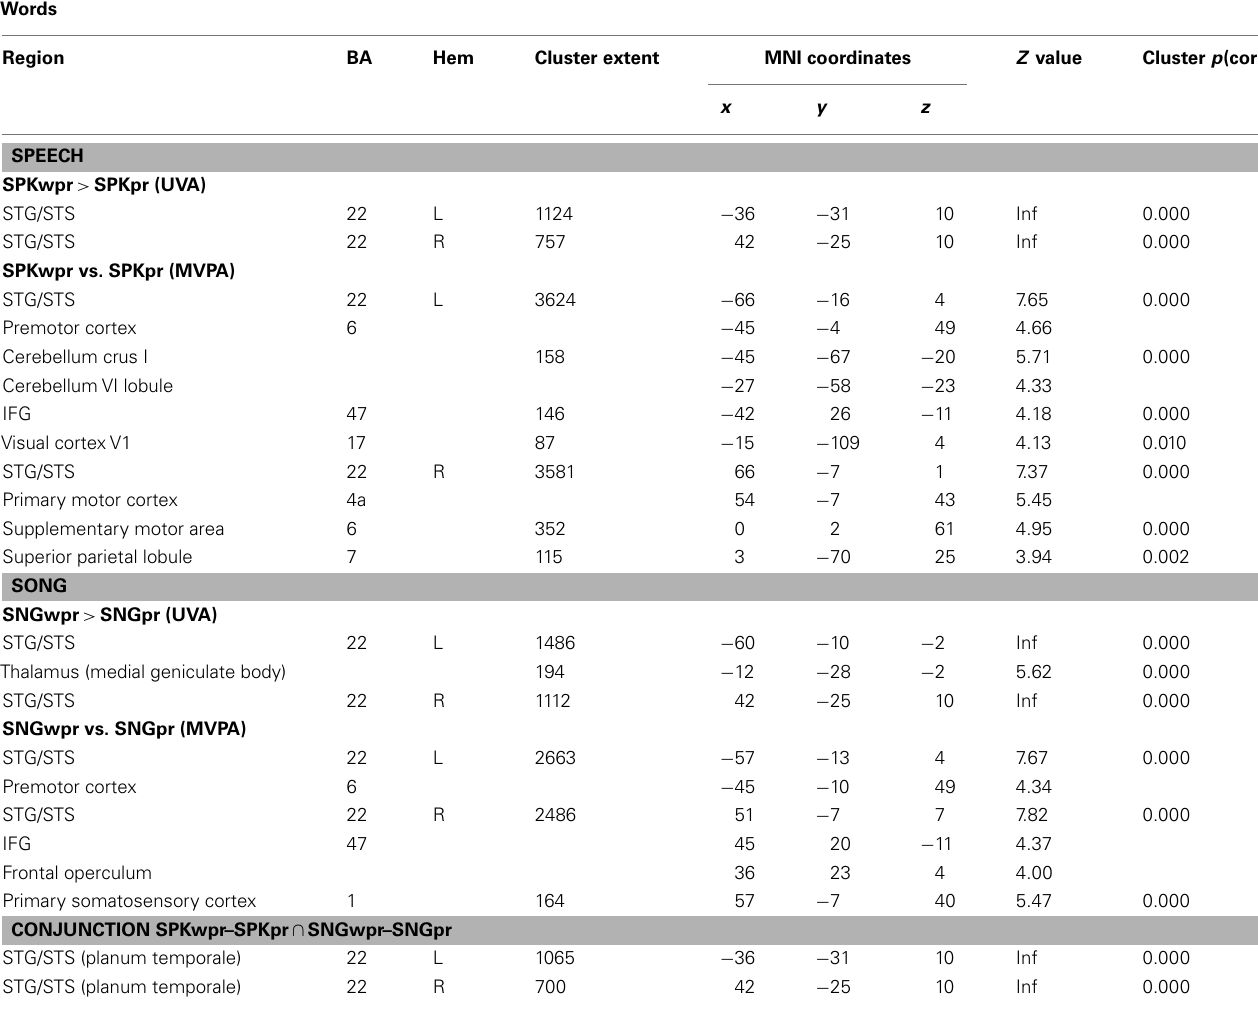
Table 1 | Brain areas involved in the processing of words in song and